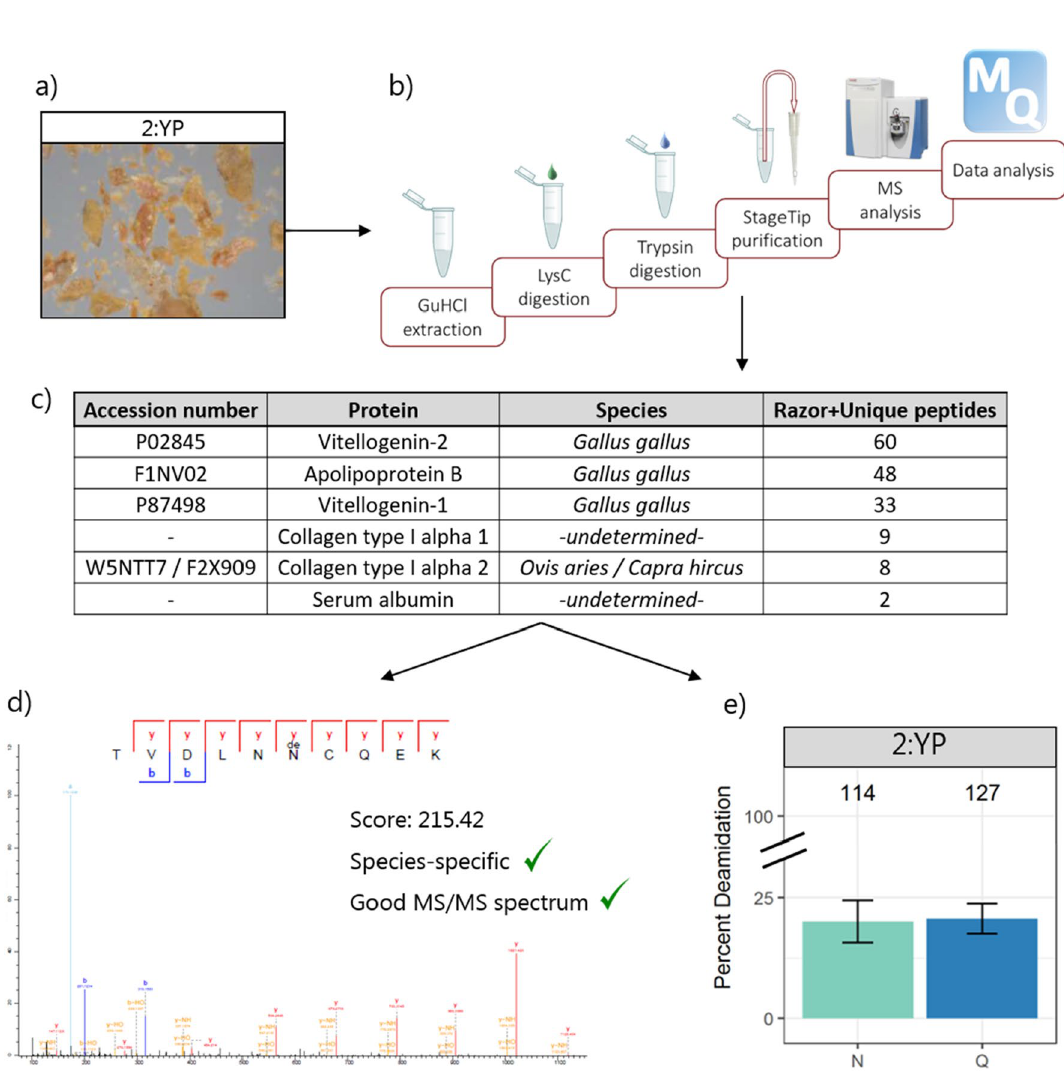
Figure 5. Scheme of the proteomic workflow for the analysis of a micro-sample from an artwork. After the sampling, the solid sample ( a ) is processed to extract and sequence proteins ( b ). The identification of the proteins present ( c ) and of their biological origin is based on the manual check of the MS/MS spectra: a good spectrum, identifying a species-specific peptide ( d ), allows species identification. Finally, the damage level of the proteins is investigated (panel e shows for example the percent deamidation